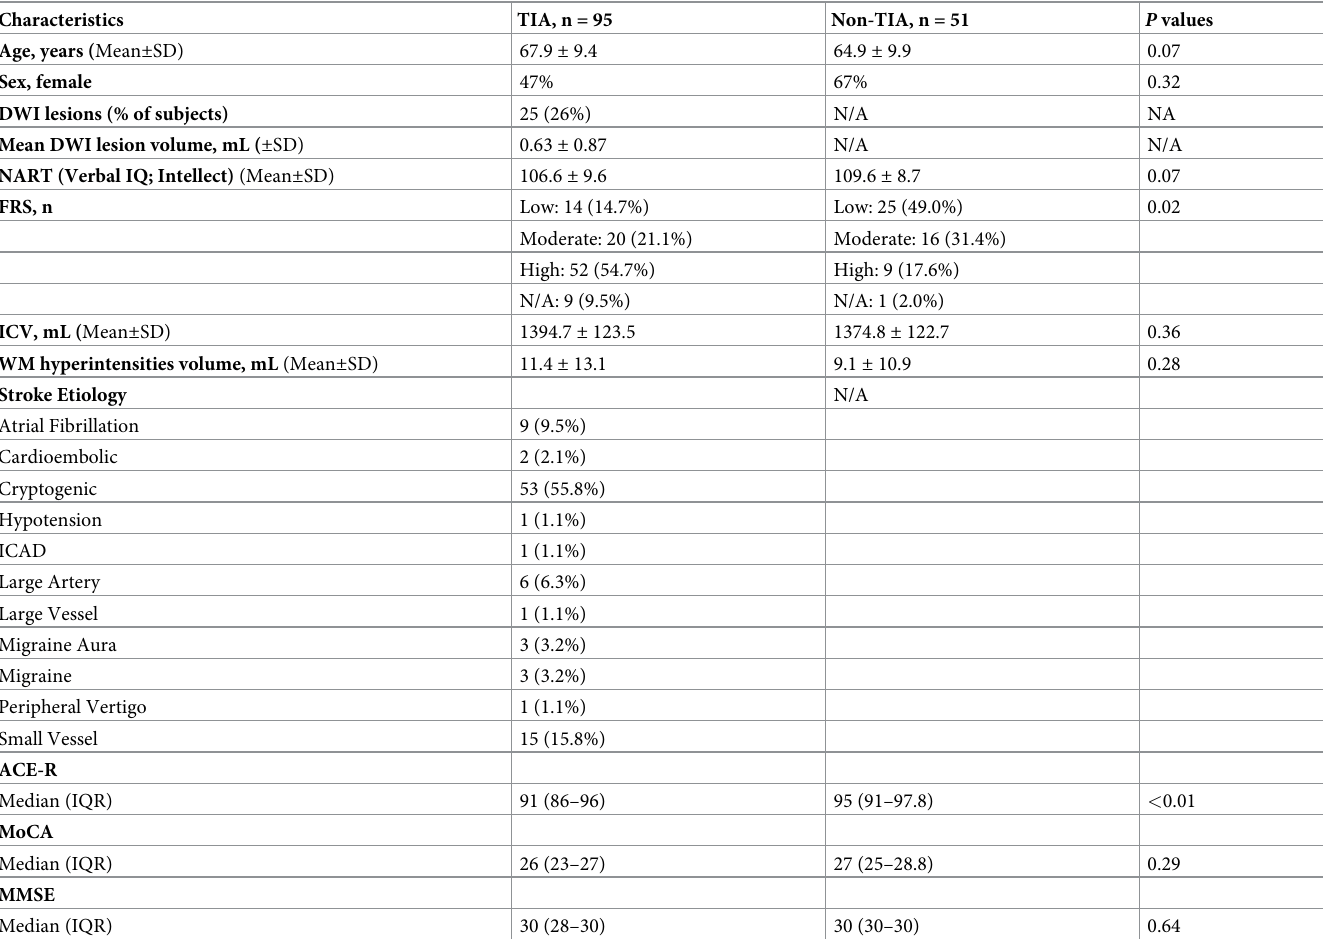
Table 1. Demographic, clinical, and cognitive screen data for PREVENT subjects.